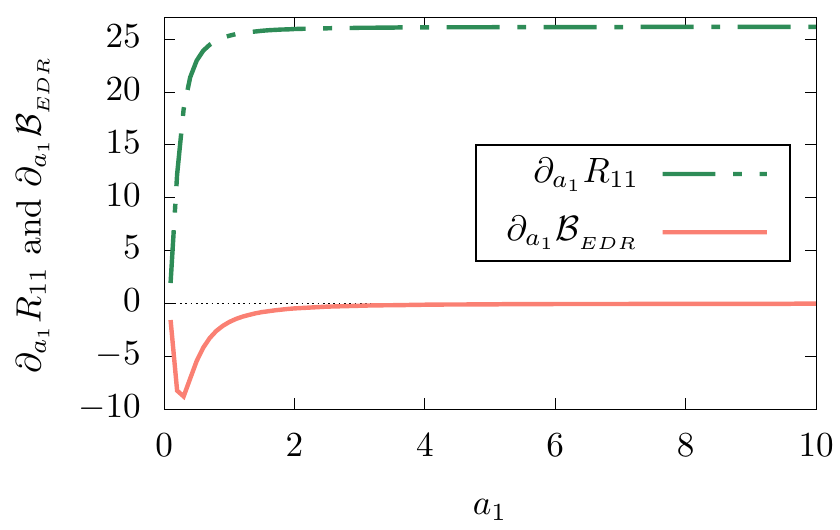
Figure 18 . The differentiation of the response function R 11 (∆ E ) , plotted with respect to varying a 1 for accelerated atoms in thermal background considering the Rindler modes in (1 + 1) dimen- sions, denoted by dash-dotted green line. In this figure the quantity ∂ a response function is also plotted, which is denoted by the solid